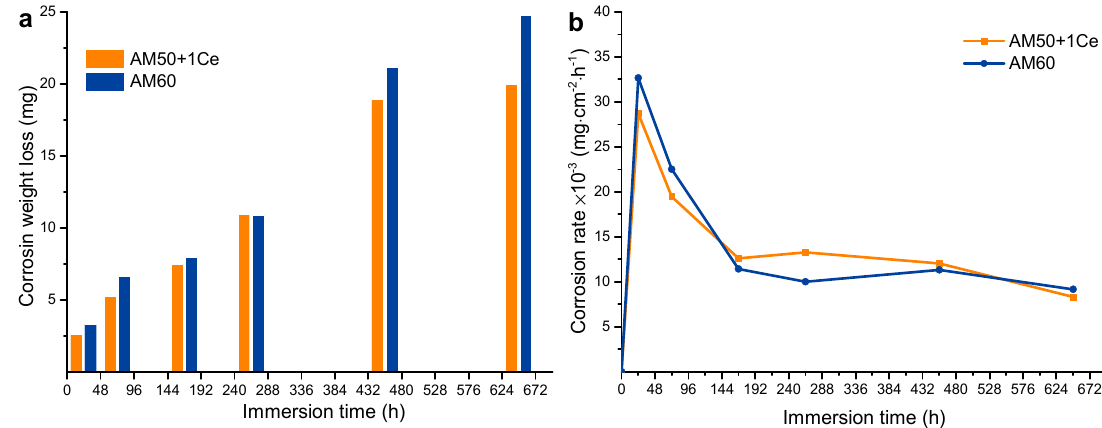
Figure 6. The weight loss ( a ) and corrosion weight rate ( b ) of HPDC AM50 + 1Ce and AM60 during immersion in 3.5 wt% NaCl solution for 648 h.